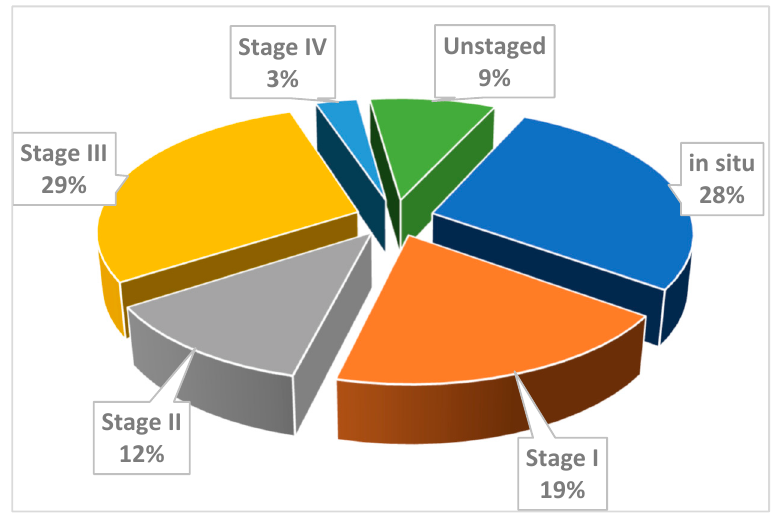
Figure 1. Distribution of new cases of cervical cancer by stages, Cluj County, 2006–2014.